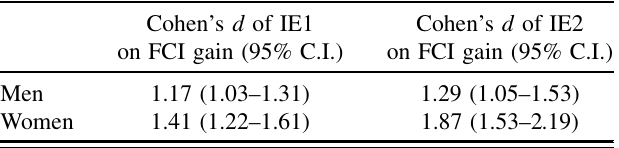
TABLE III. Effect sizes and confidence intervals of treatment for men and women in IE1 ( N men ¼ 432 , N women ¼ 251 ) and IE2 ( N men ¼ 161 , N women ¼ 99 ) derived from the data of Lorenzo et al.